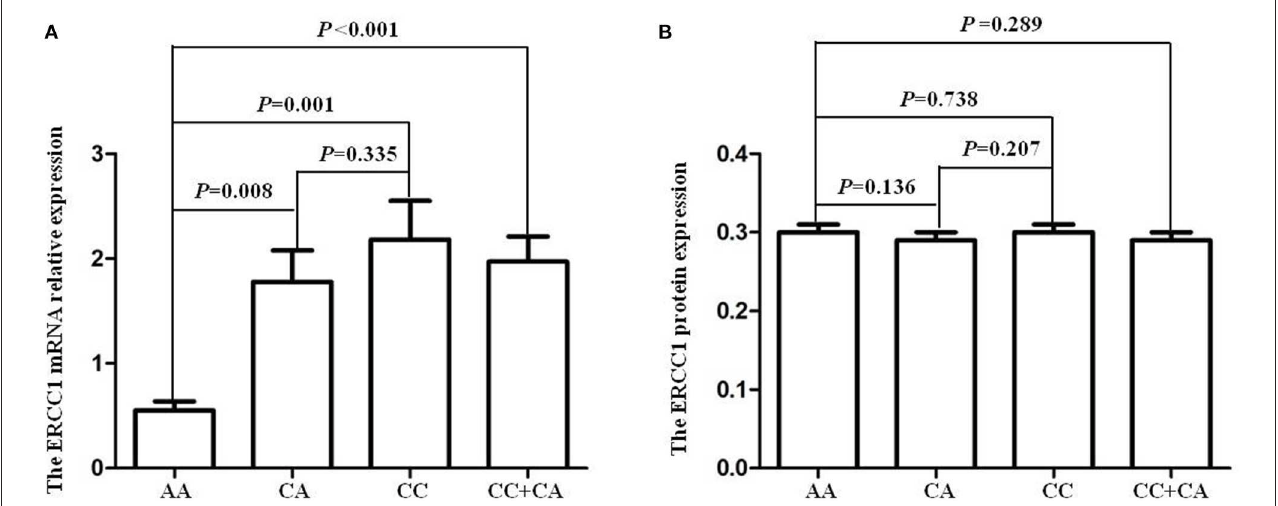
FIGURE2 ERCC1 rs3212986 polymorphism and its expression levels. (A) The individuals carrying with C allele (CC/CA genotypes) of ERCC1 rs3212986 polymorphism showed higher mRNA expression levels than those carrying the AA genotype (CC vs. AA, P = 0.001; CA vs. AA, P = 0.008; CC/CA vs. AA, P < 0.001). (B) None of the genotypes affected ERCC1 protein expression levels ( P >